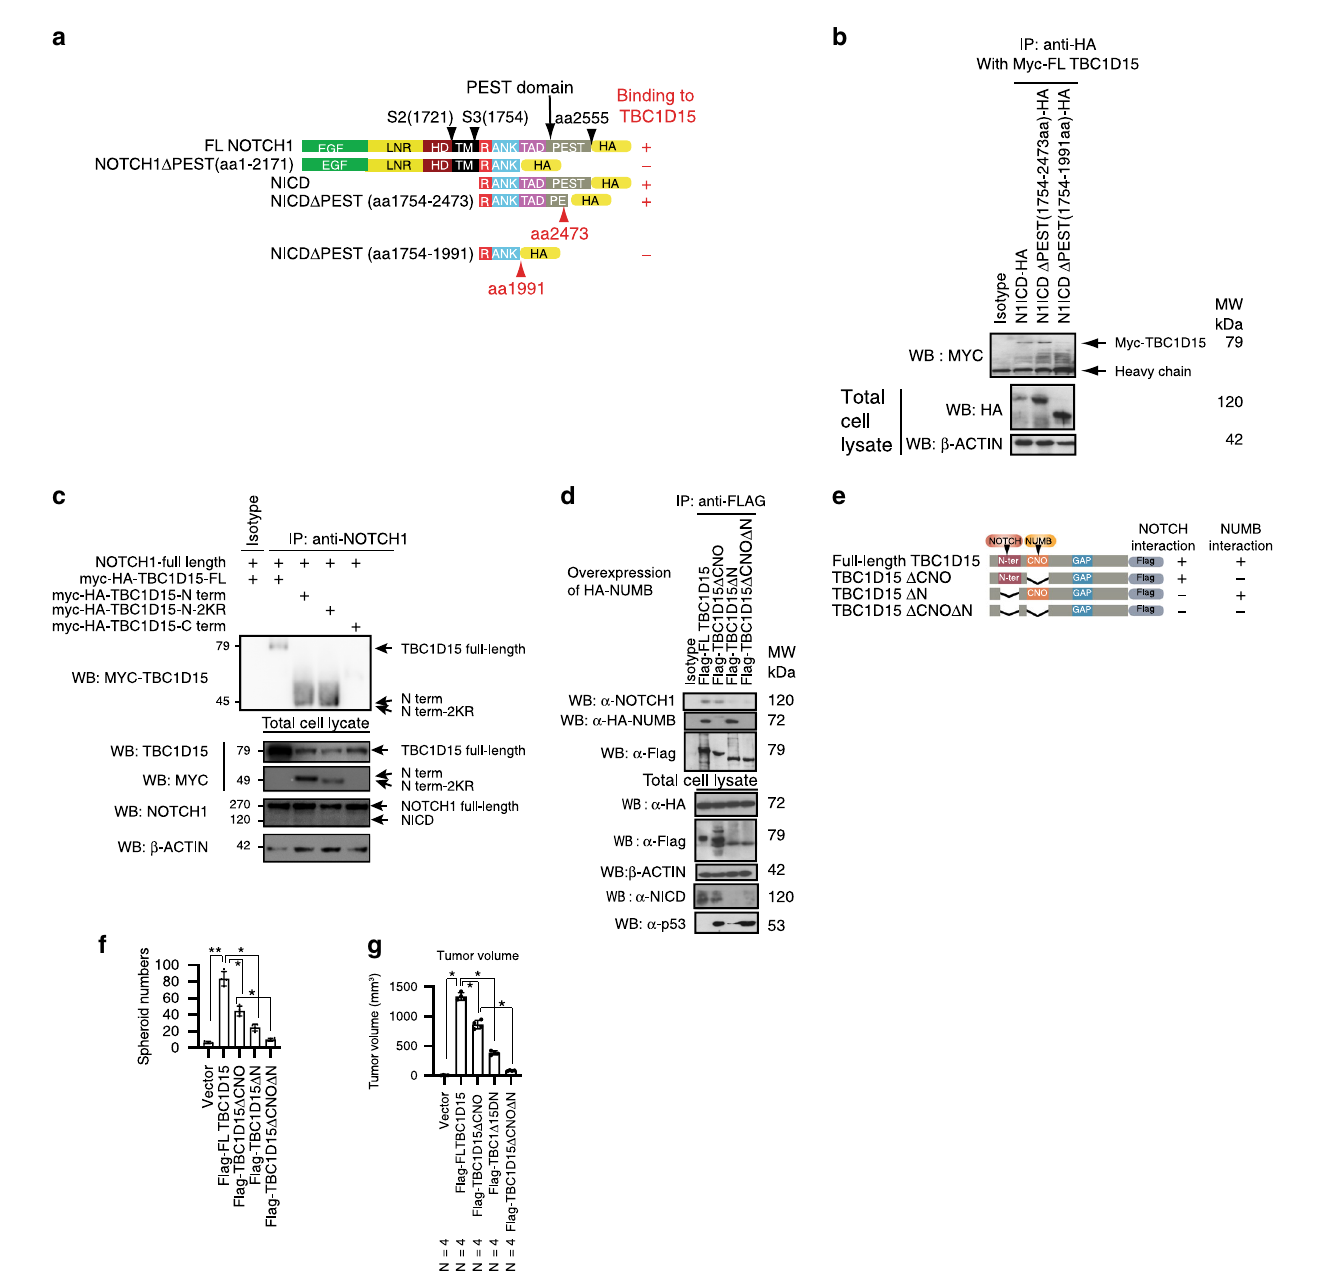
Fig. 4 NOTCH1 C-terminal PEST domain interacts with N-terminus of TBC1D15 for cooperative oncogenic activity. a Scheme representation of NOTCH- 1 deletion mutants were generated. Co-IP-Western blot analysis identi fi ed a region between aa 2171 and aa 2473 of the PEST domain as the interaction site. b Co-IP-Western blot analysis identi fi ed interaction domains of TBC1D15 interacted with intact N1ICD-HA and N1ICD Δ PEST (aa 1754 – 2473). c The N- terminus but not C-terminus of TBC1D15 interacts with NOTCH-1. A similar domain mapping of TBC1D15 for its interaction with NOTCH-1 revealed aa 1 – 200 N-terminal fragment with known lysine residues for ubiquitination (Myc-HA-TBC1D15-N term) but not the C-terminus (Myc-HA-TBC1D15-C term), interacted with NOTCH-1. Substitution of these lysines with arginine (Myc-HA-TBC1D15-N 2KR) did not affect the binding. d Co-IP/IB showed TBC1D15 – NOTCH1 interaction was lost by deletion of the N-terminus interacting domain ( Δ N) while the TBC1D15 – NUMB interaction was lost by deletion of the CNO domain ( Δ CNO). NICD expression was lost when TBC1D15 with Δ N was expressed while p53 was restored when TBC1D15 with Δ